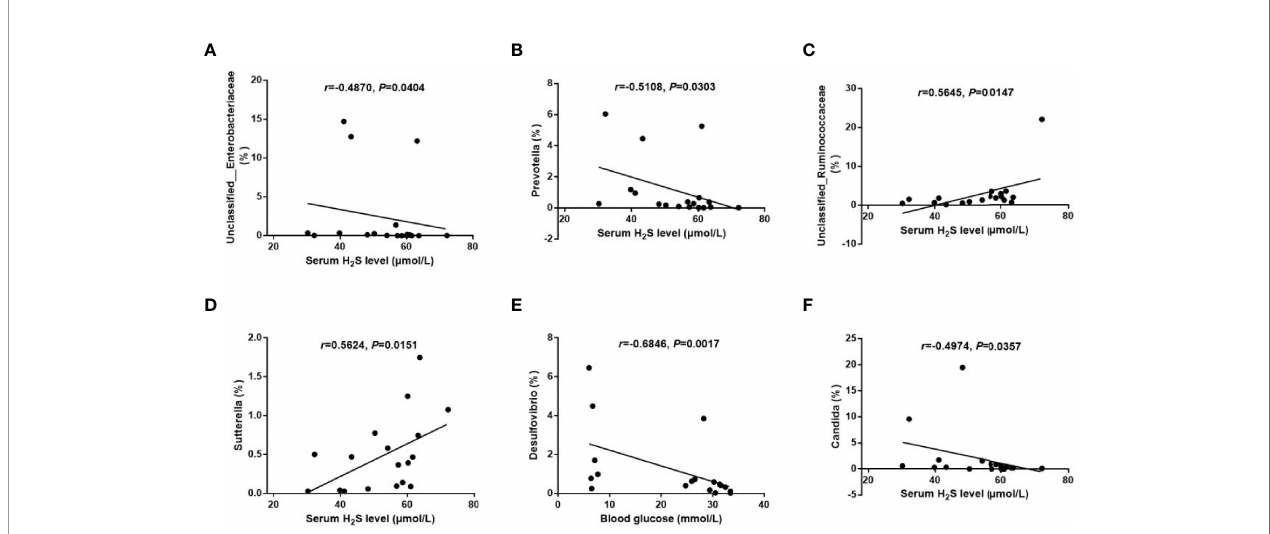
FIGURE 7 | Correlations between the metabolic parameters and the gut microbiota abundance. (A – D) : Correlations of the serum H 2 S level with the abundance of bacterial genera Unclassi fi ed_Enterobacteriaceae (A) , Prevotella (B) , Unclassi fi ed_Ruminococcaceae (C) , and Sutterella (D) . (E) Correlation of the blood glucose level with the abundance of bacterial genus Desulfovibrio . (F) Correlation of the serum H 2 S level with the abundance of fungal genus Candida. The data were analyzed by Spearman correlation